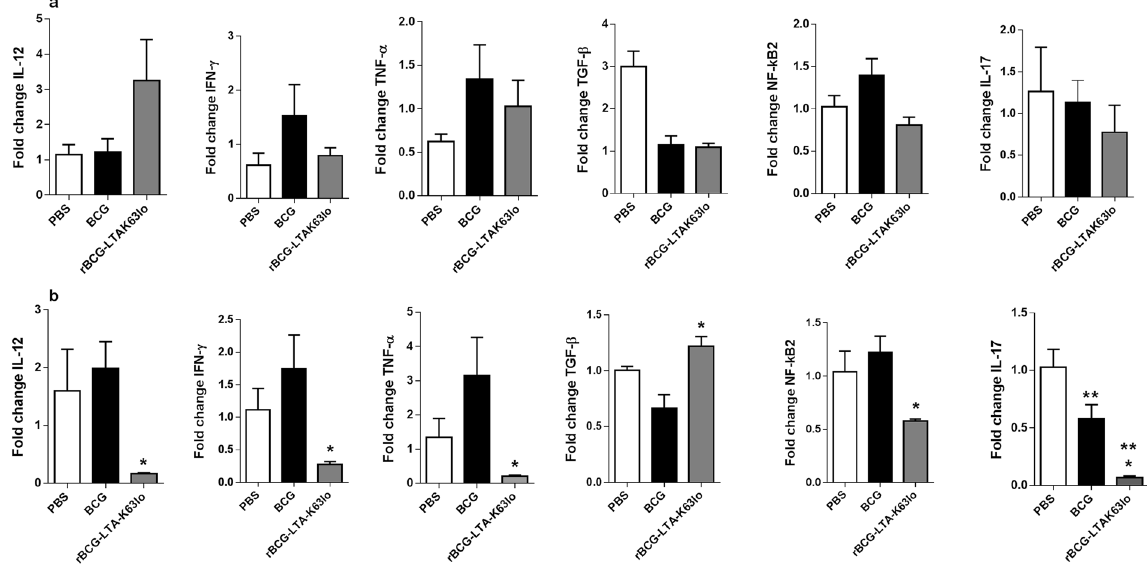
Figure 5. Cytokine production in the lungs of BALB/c mice immunized with rBCG-LTAK63 lo and challenged with Mtb as evaluated by Real-Time RT-PCR. Lung tissue from mice immunized with BCG or rBCG-LTAK63 lo were collected 30 days post-challenge with either ( a ) Mtb H37Rv (1 × 10 5 UFC) or ( b ) a higher dose of Mtb H37Rv (1 × 10 7 UFC) and cytokine mRNA expression fold changes of IL-12, IFN- γ , TNF- α , TGF- β , NF- κ B2 and IL-17, were analyzed by Real-Time RT-PCR. Differences were considered statistically significant when P ≤ 0.05 as compared to ( * ) BCG or ( ** ) compared to PBS (one-way Anova). Target gene expression was normalized as compared to GAPDH and Actin